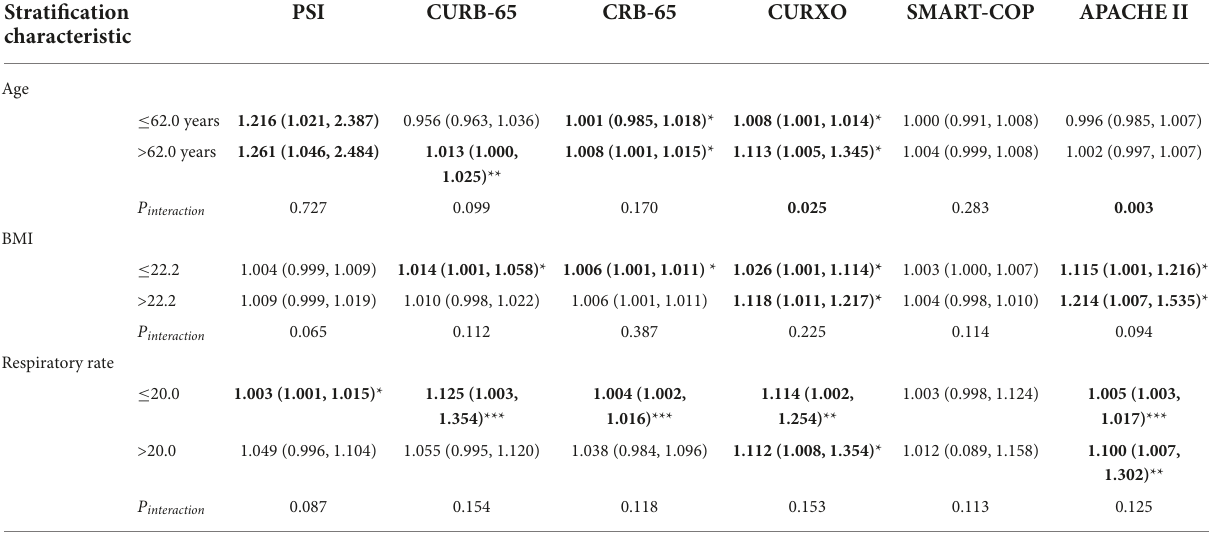
TABLE 3 Stratified analysis for the associations between serum CYR61 and severity scores.